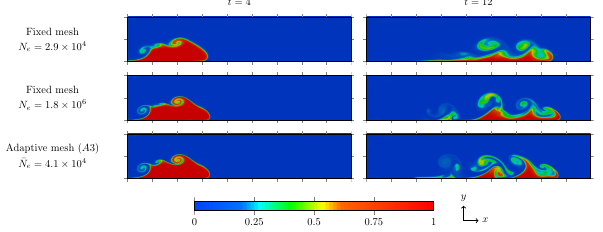
Figure 6. Heat map of sediment concentration at t = 4 and t = 12 for the highest-resolution fixed mesh simulation, the adaptive sim- ulation with configuration A3, and a fixed mesh simulation with a similar number of elements to the adaptive